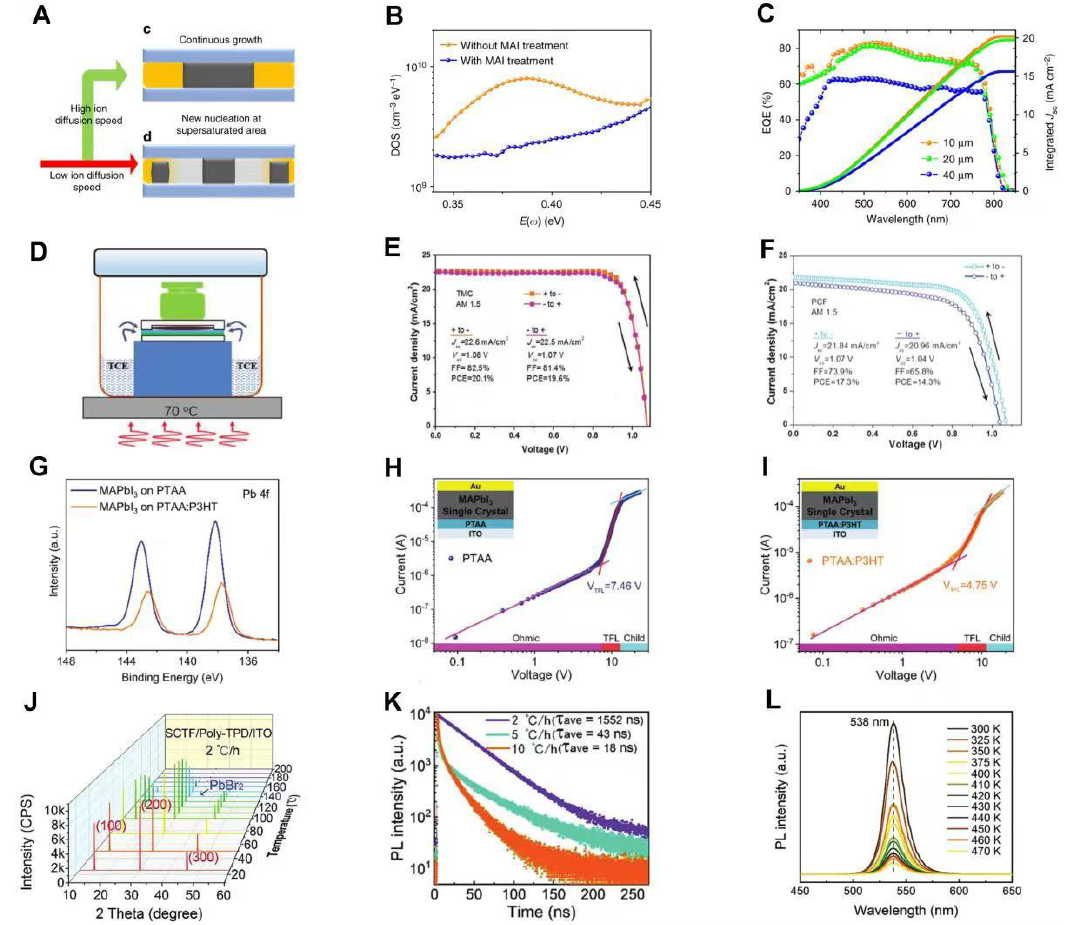
Figure 2. ( A ) The process of growing a single crystal by space restriction. ( B ) Thermal admittance spectroscopy of the single crystals after surface treatment. ( C ) Incident photon − to − electron conver- sion efficiency (IPCE) and integrated J SC of solar cells with different thickness [34]. Copyright 2017, Springer Nature. ( D ) The process of growing a single crystal by the AVC method. ( E) Plot of current density versus voltage for a single crystal device. ( F ) Plot of current density versus voltage for a polycrystalline device [35]. Copyright 2020, Wiley. ( G ) The X − ray photoelectron spectroscopy (XPS) of Pb 4 f for the samples with or without the addition of P3HT. ( H ) J – V curve of the device with PTAA as the hole transporting layer (HTL). ( I ) J – V curve of the device with PTAA:P3HT as the HTL [36]. Copyright 2022, Wiley. ( J ) In situ XRD patterns of MAPbBr 3 single crystals grown at 2 °C per hour. ( K ) Time − resolved photoluminescence (TRPL) at different heating rates. ( L ) PL spectrum of single crystals from 300 to 470 K [37]. Copyright 2022, Wiley.